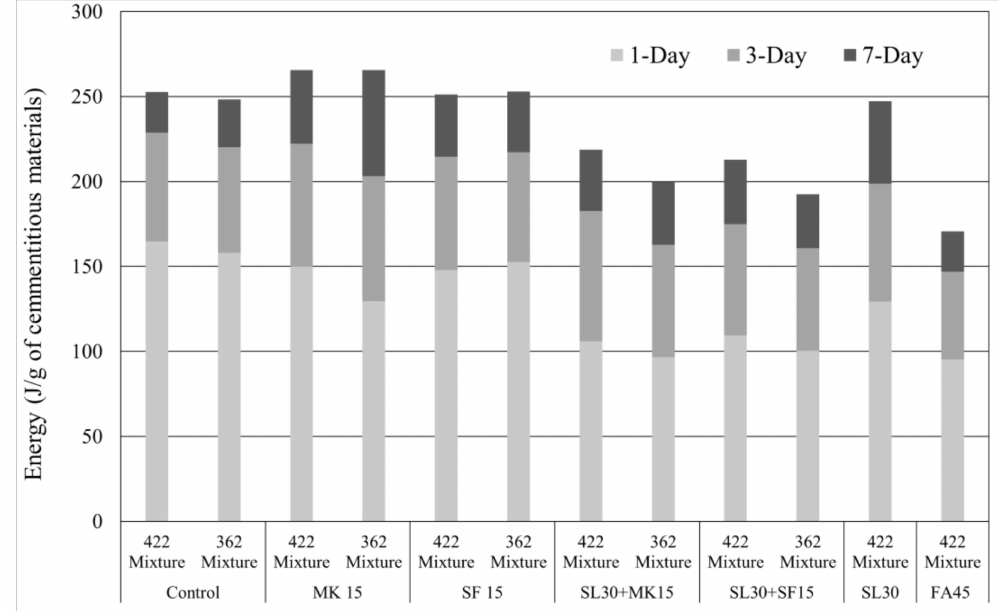
Figure 2. Heat of hydration of 422 and 363 mixture